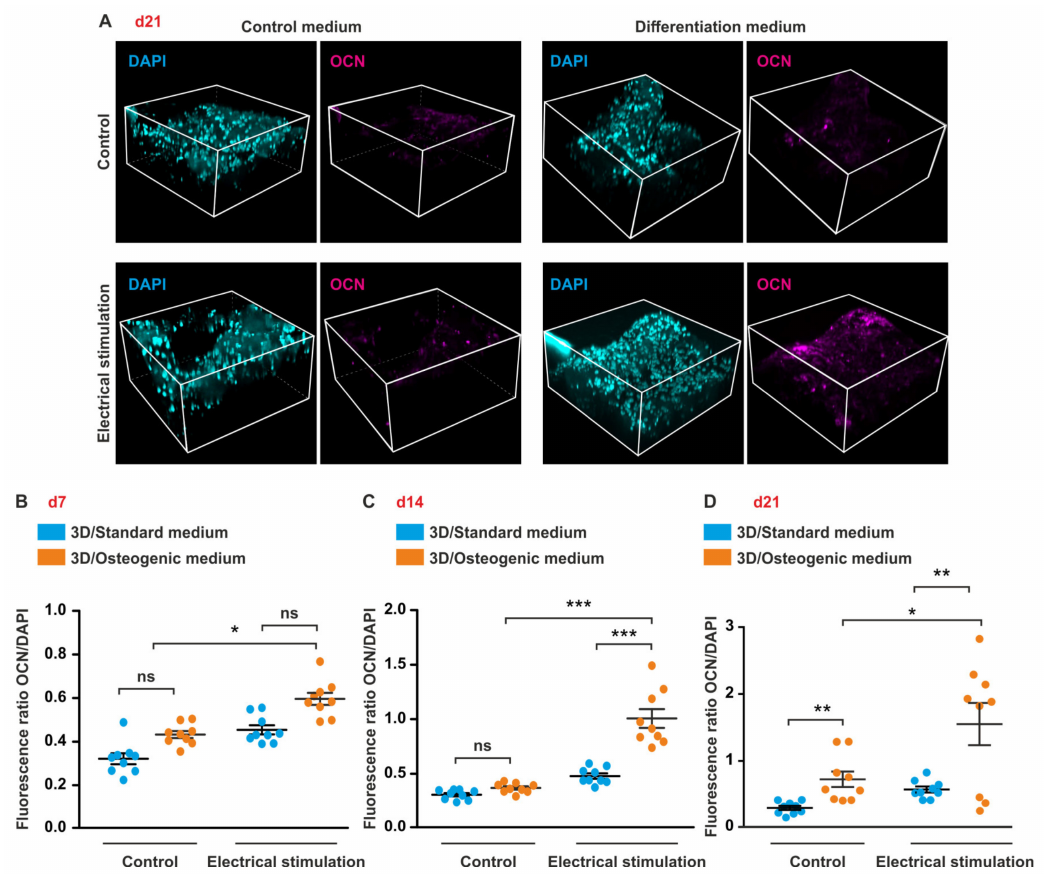
Figure 6. Electrical stimulation (ES) increases expression of osteocalcin (OCN) in 3D. ( A – D ) ES increases expression of OCN in 3D. ( A – D ) ASCs in osteogenic or standard medium were electrically stimulated for up to 21 days and stained for OCN. Images were taken using confocal microscopy with subsequent 3D reconstruction. ES significantly increased the expression of OCN in cells in osteogenic medium compared to stimulated cells in standard medium and osteogenic medium not exposed to ES at d14 and d21. Error bars: SEM. * p < 0.05, ** p < 0.01, *** p < 0.0001. ns: not